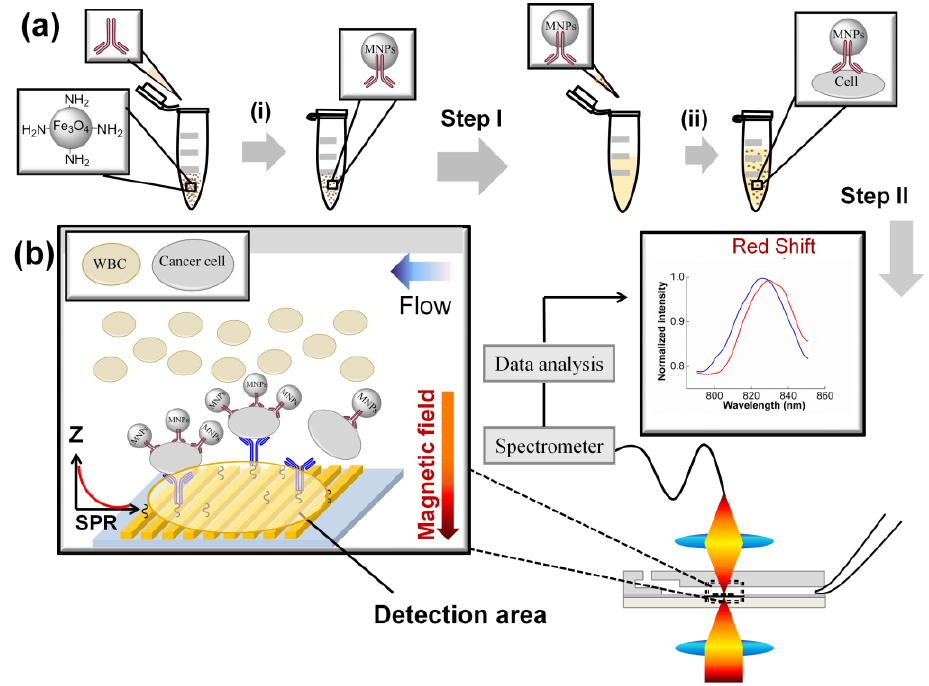
Figure 1. A schematic of DCM. ( a ) The first step includes: ( i ) Functionalizing the MNPs with antibody I; ( ii ) Mixing the functionalized MNPs (carrying antibody I) with the sample to capture the target cells. ( b ) The second step includes introducing the mixture of blood sample and MNPs to the microfluidic chip and capturing the MNPs-cells to binds to the antibody II on the gold nanoslits. The cell binding on the gold nanoslits was monitored by the wavelength shift of the SPR spectrum generated by the gold nanoslits. The detection area of the nanoslits is defined by the focal spot of the probe